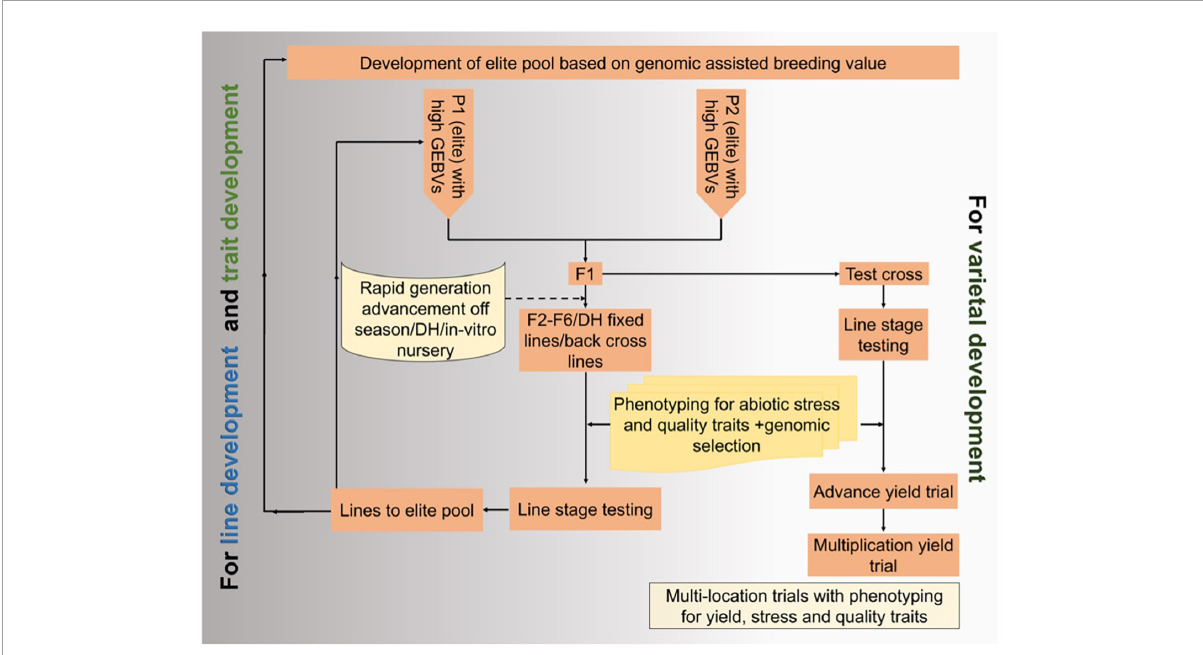
FIGURE4 Integration of speed breeding and genomic selection in maize cultivar improvement and